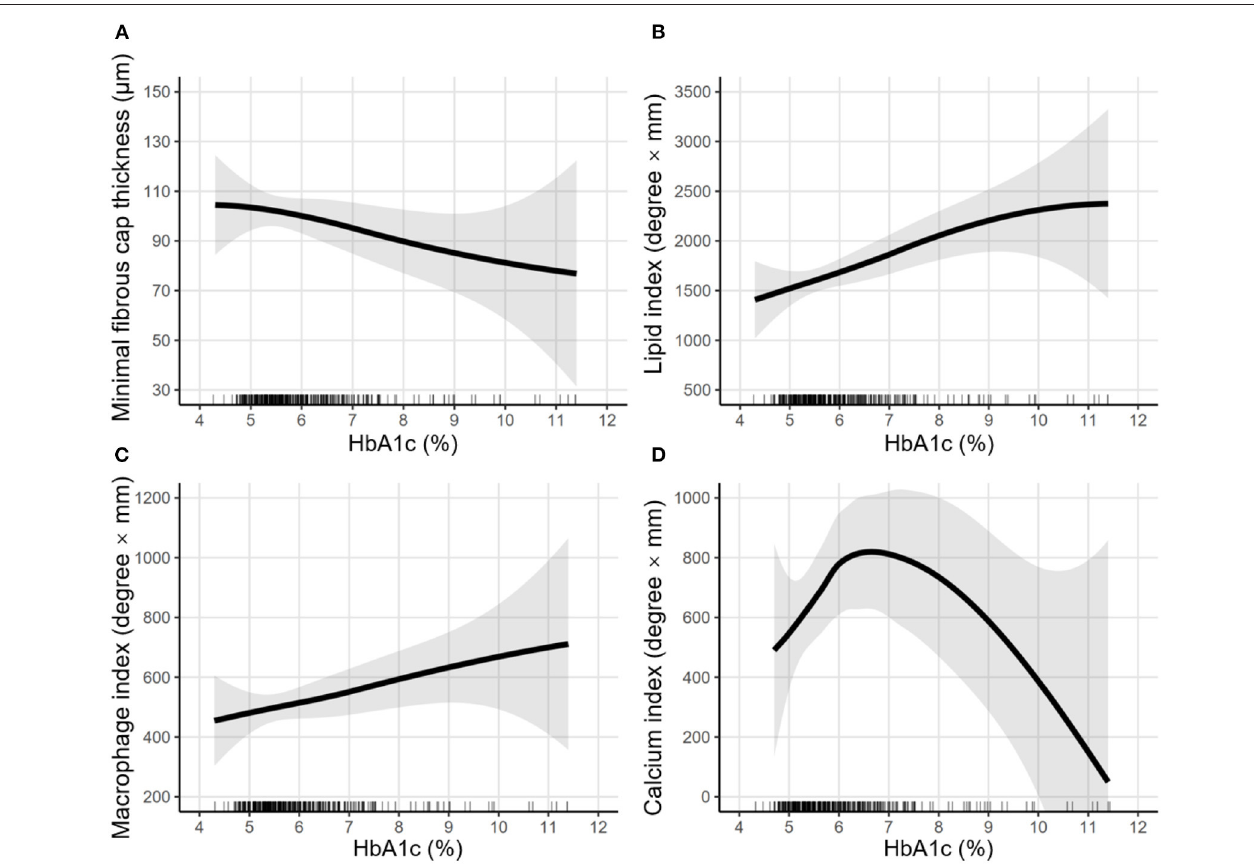
FIGURE 3 | LOWESS curves of the association between pre-procedural HbA1c levels and vulnerability features. Locally weighted scatterplot smoothing (LOWESS) curves were used to visualize the rough association between pre-procedural HbA1c levels and vulnerability features, including (A) minimal fibrous cap thickness, (B) lipid index, (C) macrophage index, and (D) calcium index. The semi-transparent ribbon around the solid line indicates the 95% confidence interval. Rug plots show the distribution of pre-procedural HbA1c levels.